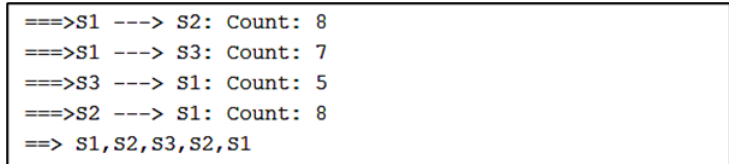
Figure 11. Algorithm 2 ’ s output for Path 1.